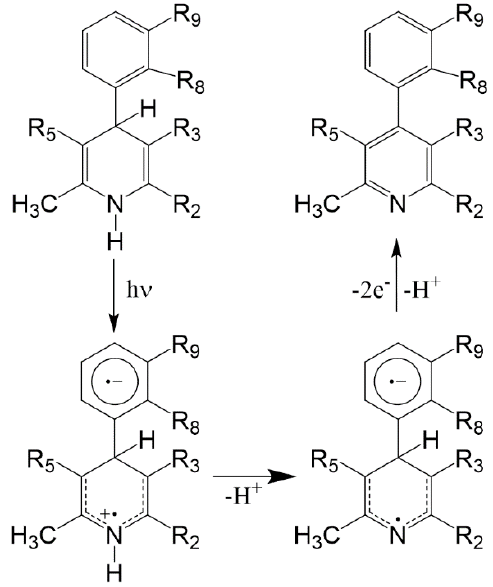
Figure 1. Hypothesized mechanism of the photodegradation process of 1,4-dihydropyridine (DHP) drugs causing potential phototoxicity.